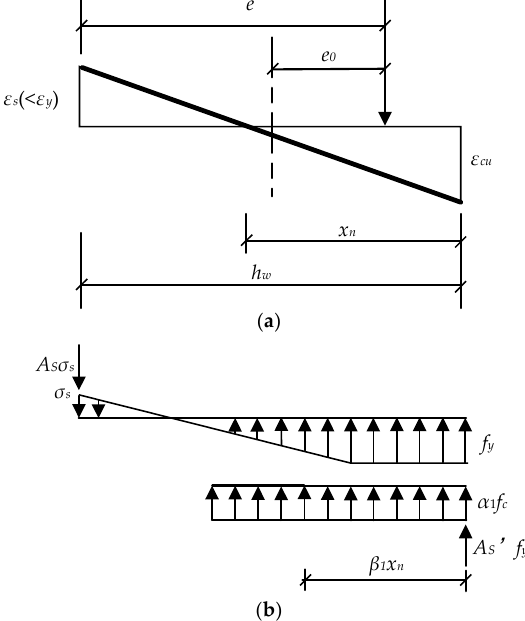
Figure 10. Stress and strain distribution of cross section for the small eccentric SC wall. ( a ) Strain distribution of cross section; ( b ) Stress distribution of cross section.